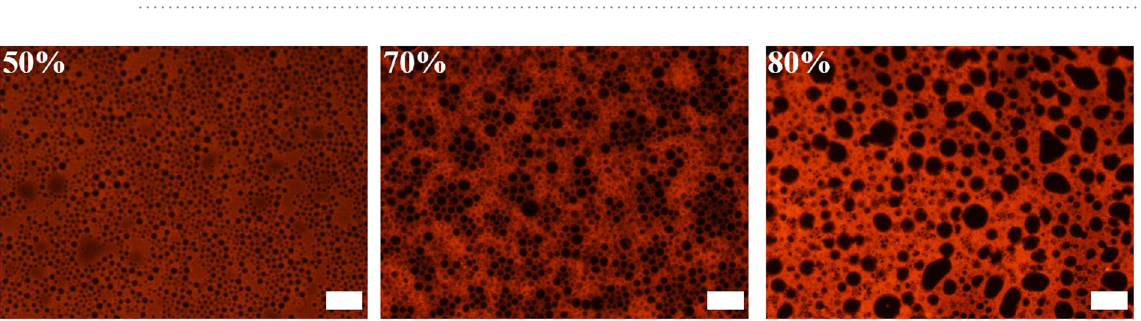
Figure 2. Photographs of emulsions with toluene as the oil stabilized by S-PBzMA with different concentrations of ( a ) 0.5 wt%, ( b ) 3.0 wt%, and ( c ) 5.0 wt%, respectively. The percentage number on the vial represents the water volume fraction ( V w ).